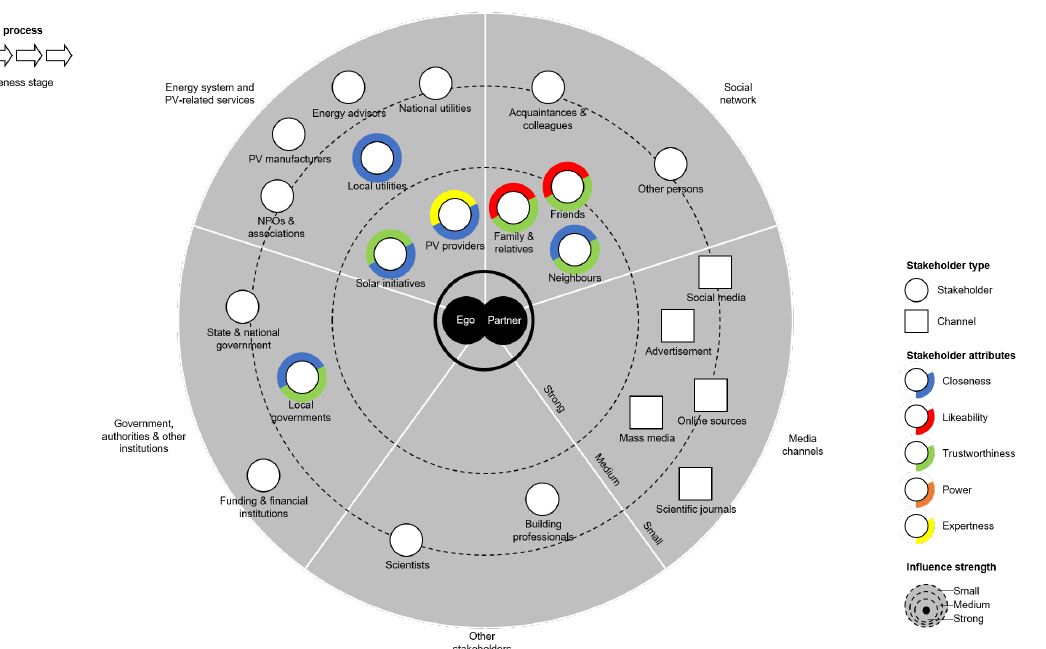
Figure 3. Visual representation of the egocentric network of the stakeholder dynamics at the awareness stage. The focus is on residential PV adoption from the perspective of the household decision-maker (own illustration).